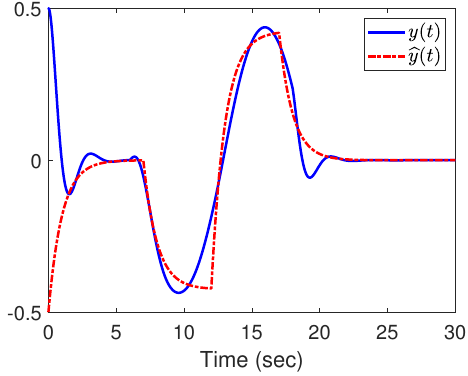
Figure 11. The trajectories of y ( t ) and (cid:98) y ( t )